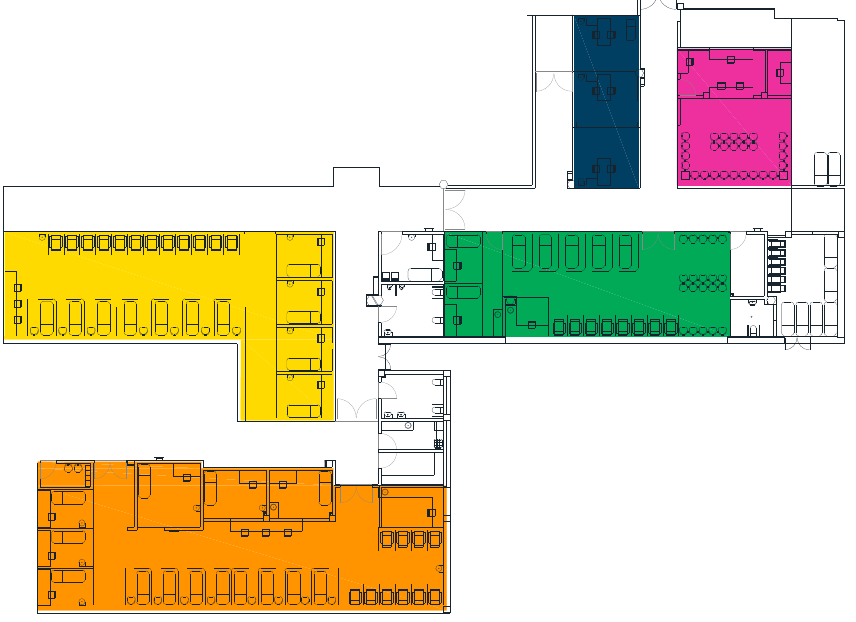
Figure 3. Overview of the future emergency department.